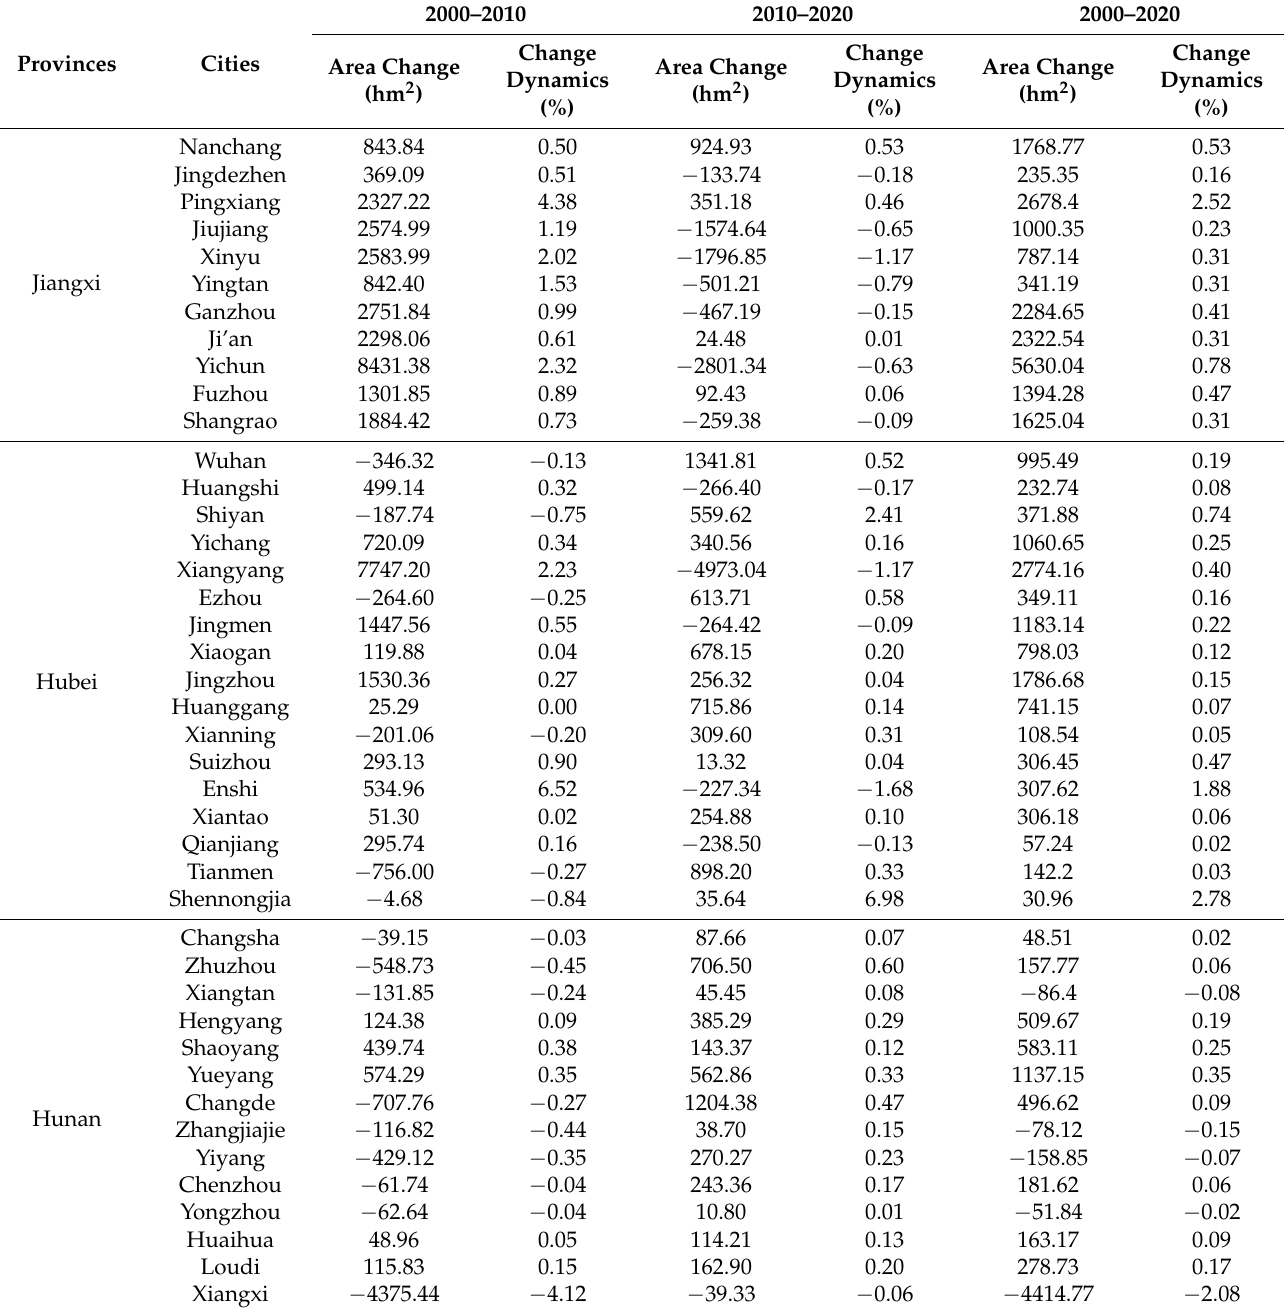
Table 4. Statistics on the RRL area change in 42 cities in the